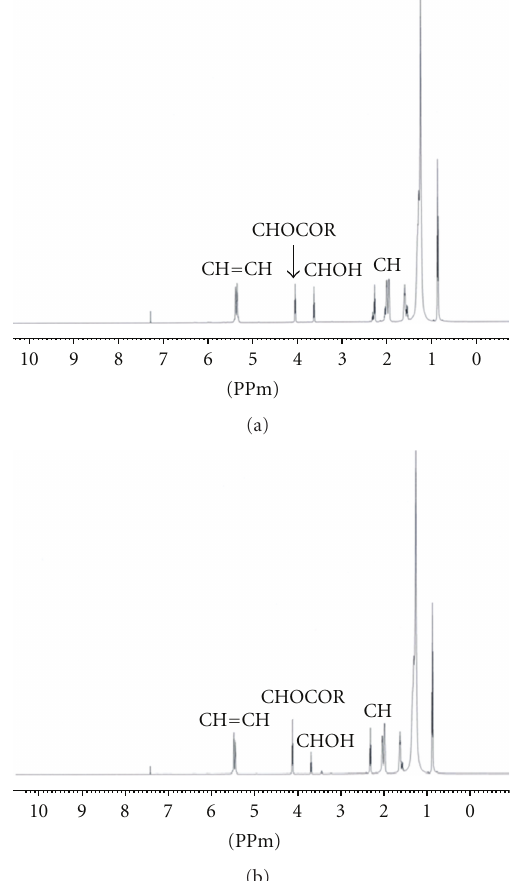
Figure 6: 1 H NMR spectrum of HYOOA (a) and OLHYOOD